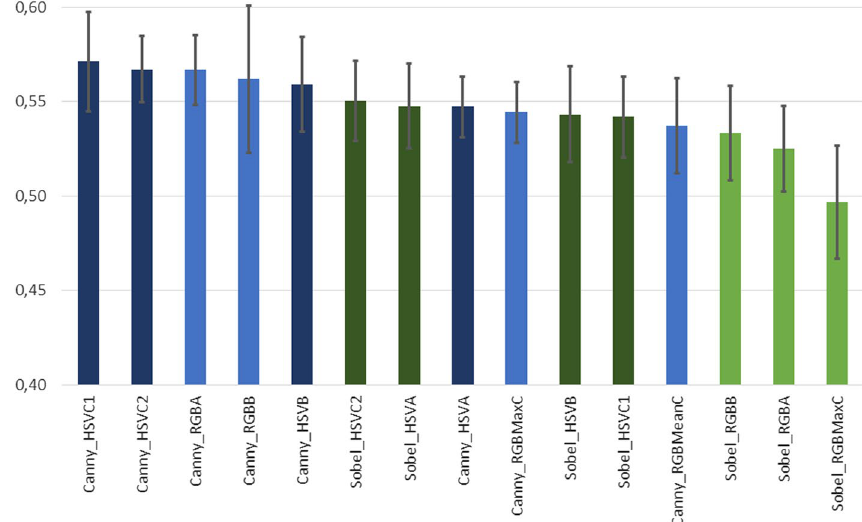
Fig. 5 F 1 medians and standard errors for all methods (closest human)